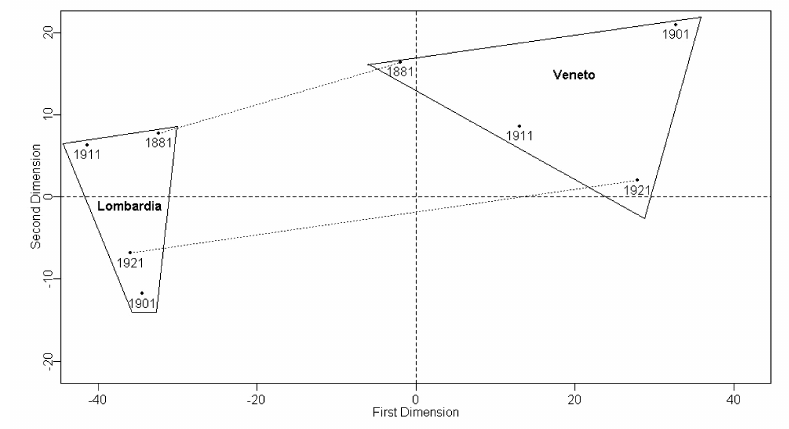
Figure 7 − Trajectories drawn by Lombardia and